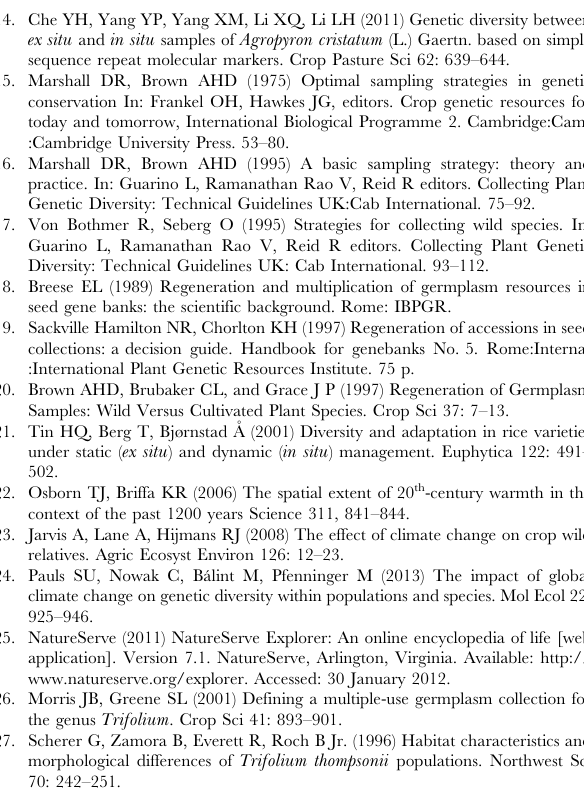
Figure S1 The plot of P(X|K) indicated that K =2 and K = 4 were the most likely groupings. (TIF) Table S1 Results from resampling to determine unequal sample bias.